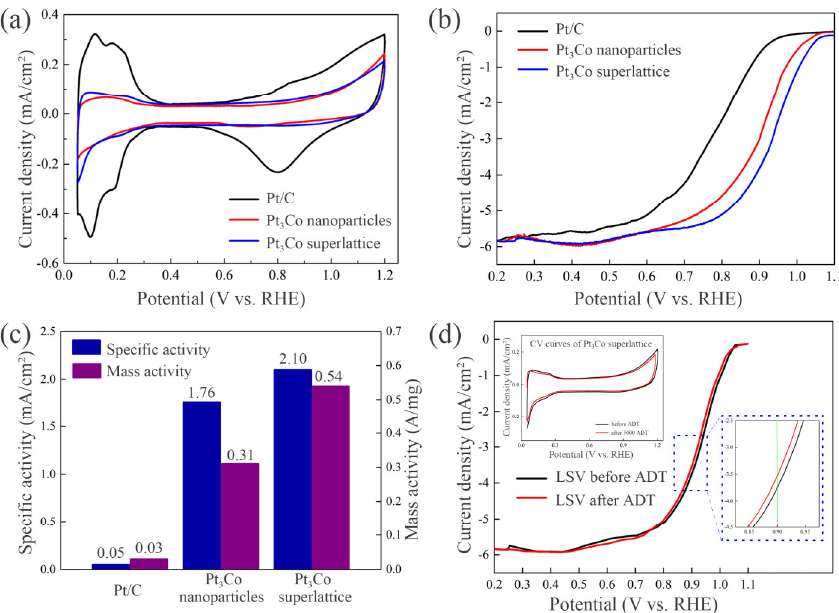
Figure 2. ( a ) Cyclic voltammograms of Pt 3 Co superlattice arrays, Pt 3 Co nanoparticles, and Pt/C. ( b ) Liner sweep voltammograms of Pt 3 Co superlattice arrays, Pt 3 Co nanoparticles, and Pt/C. ( c ) MA and SA of all the catalysts at 0.9 V versus RHE. ( d ) CV and LSV curves of Pt 3 Co superlattice arrays before and after 5000 cycles ADT.